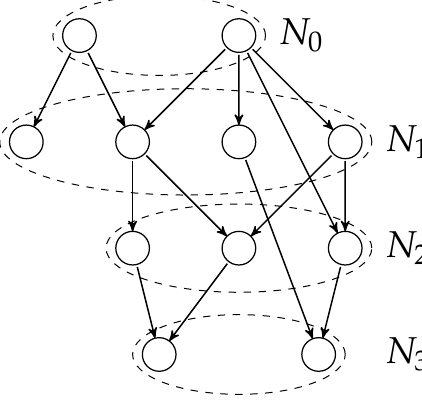
Figure 4. Nodes structure in